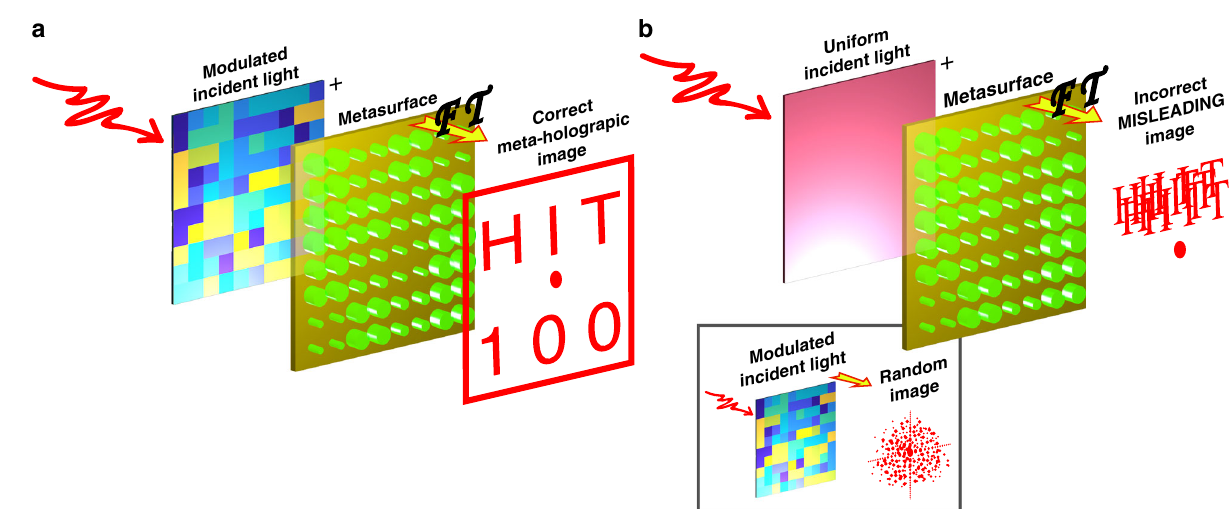
Fig. 1 The working principle of reprogrammable meta-hologram. a The schematic of the meta-holographic image with the modulated incident beam. b The holographic image of metasurface when it is illuminated with an incorrect uniform laser beam. The inset shows that the incident beam itself cannot provide correct information.